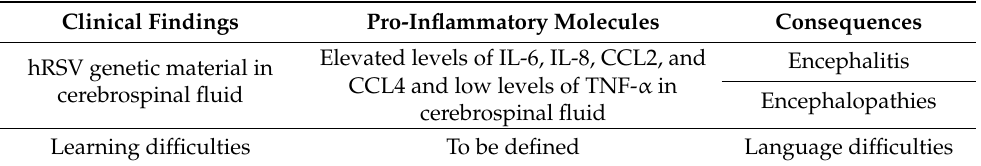
Table 2. Cytokines elicited by hRSV infection in CNS and the associated